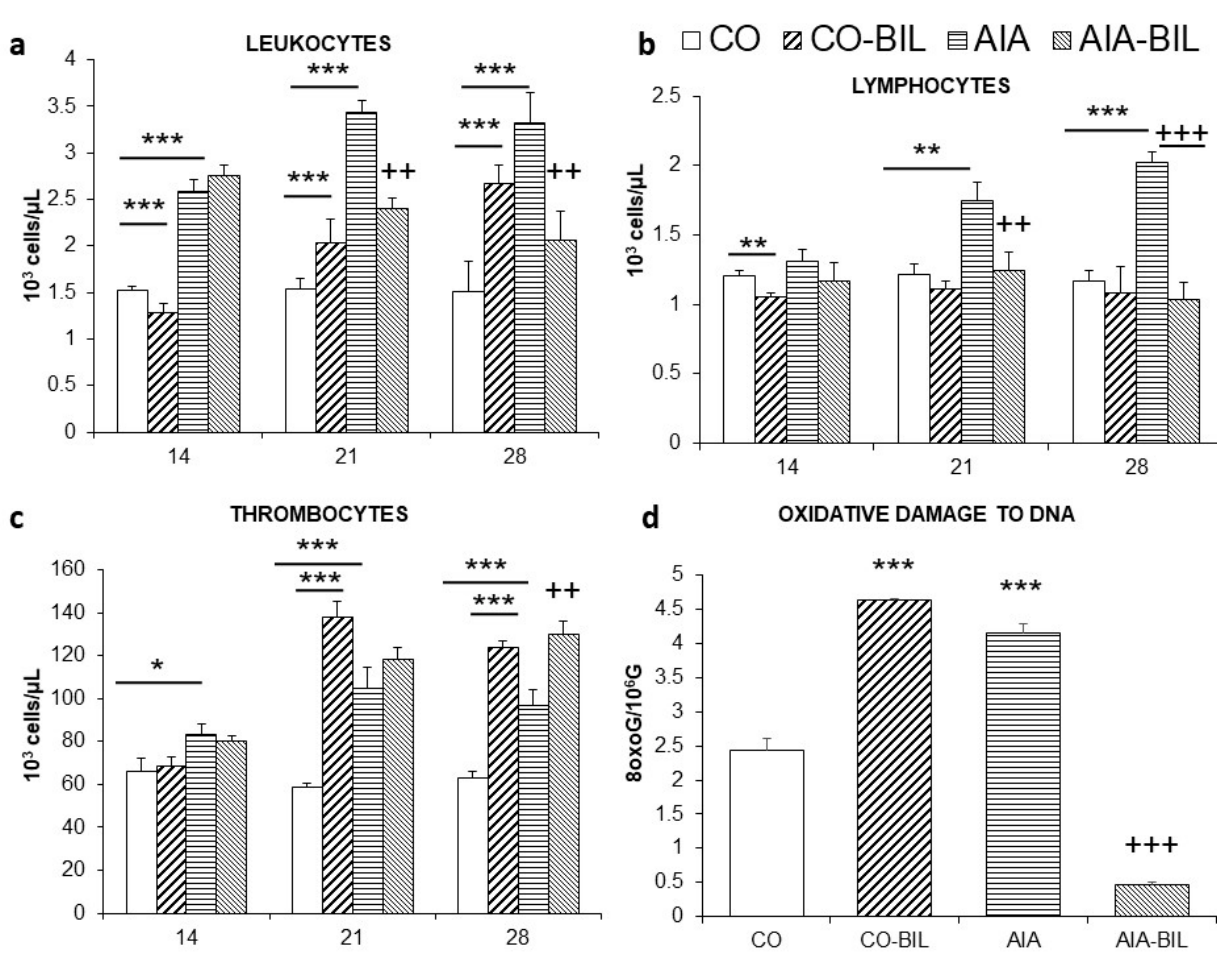
Figure 2. Time profile of changes in ( a ). leukocytes, ( b ). lymphocytes and ( c ). thrombocytes ( d ). Oxidative damage to DNA evaluated on day 28 of the experiment CO—control group, CO-BIL—control group administered with UCB 200 mg/kg of body weight daily i.p. from day 14, AIA—group with adjuvant induced arthritis, AIA-BIL—group with adjuvant induced arthritis administered with UCB 200 mg/kg of body weight daily i.p. from day 14. Results are expressed as mean ± SEM, n = 7–8. Significant difference between groups CO and CO-BIL, CO and AIA: *** p < 0.001 vs. CO, ** p < 0.01 vs. CO, * p < 0.05 vs. CO. Significant difference between groups AIA and AIA-BIL: +++ p < 0.001 vs. AIA, ++ p < 0.01 vs.